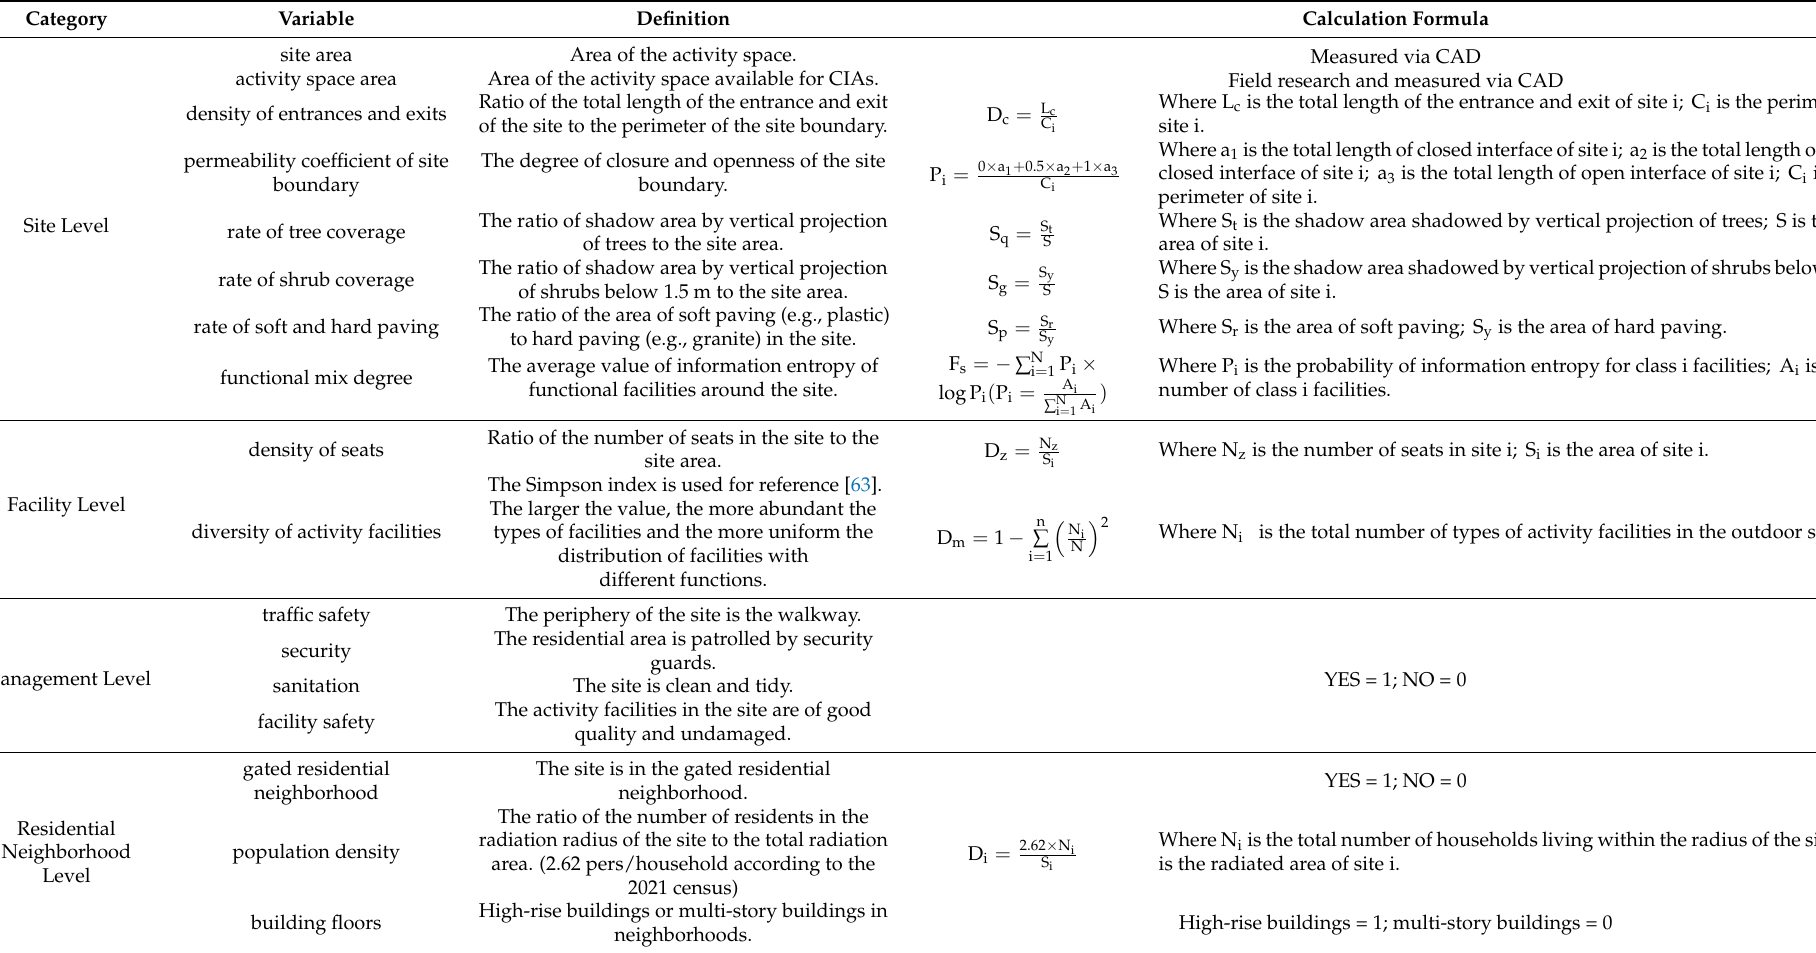
Table 2. Definition and calculation formula of built environment